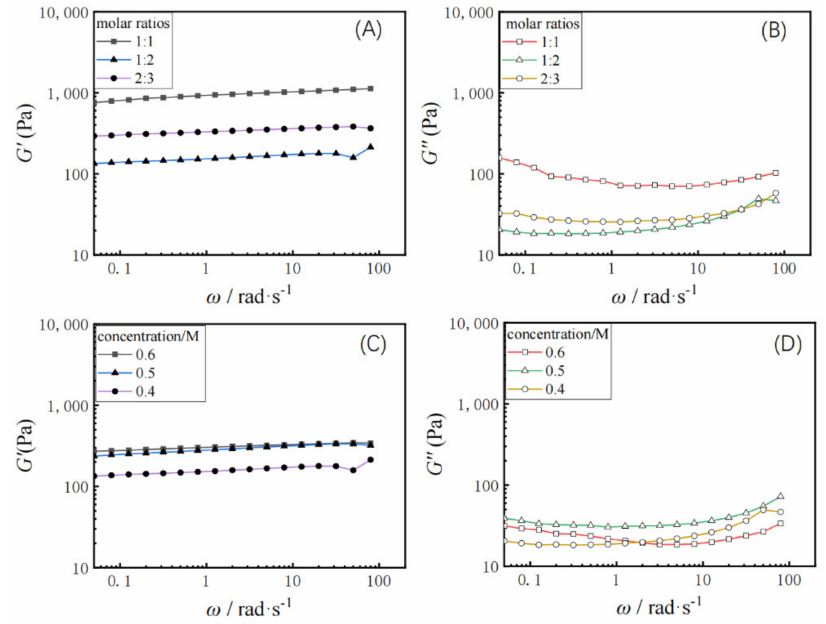
Figure 3. Variation of elastic modulus G (cid:48) and viscous modulus G” with shear frequency ( ω ) at 25 ◦ C for hydrogels with different molar ratios ( A , B ) and with different concentration ( C , D